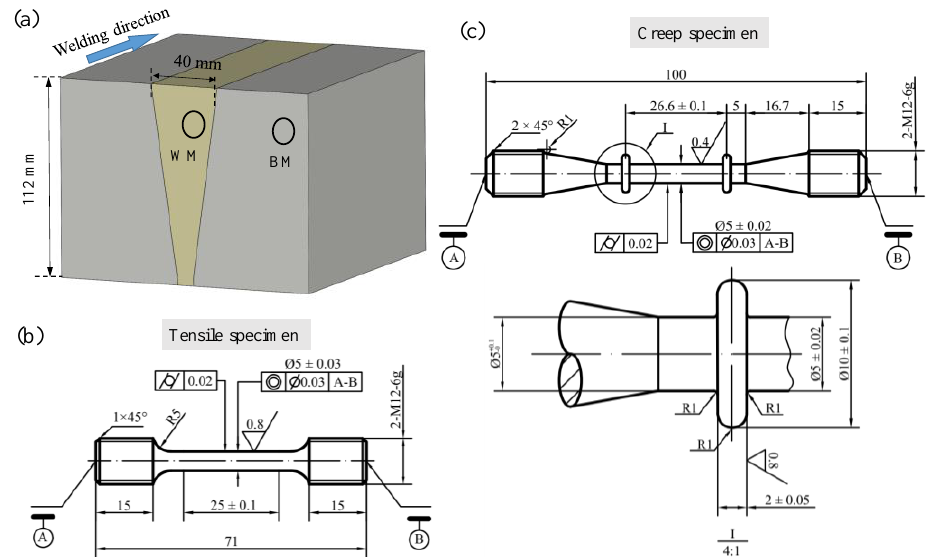
Figure 1. ( a ) Schematic for extracting specimens from the 2.25Cr1Mo0.25V steel weldment. Dimensions of ( b ) tensile specimen and ( c ) creep specimen. All units are in mm.